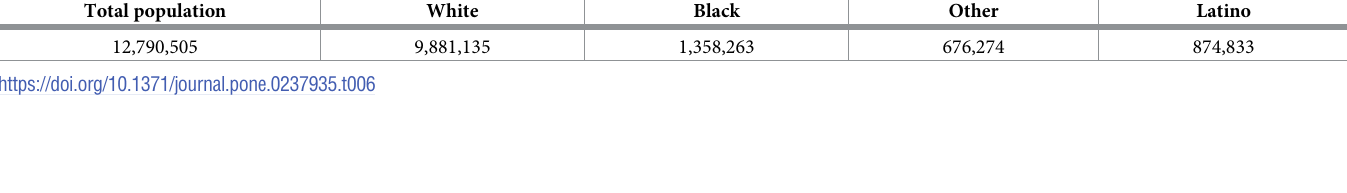
Table 6. Pennsylvania population categories from the ACS 2017 survey. Total population White